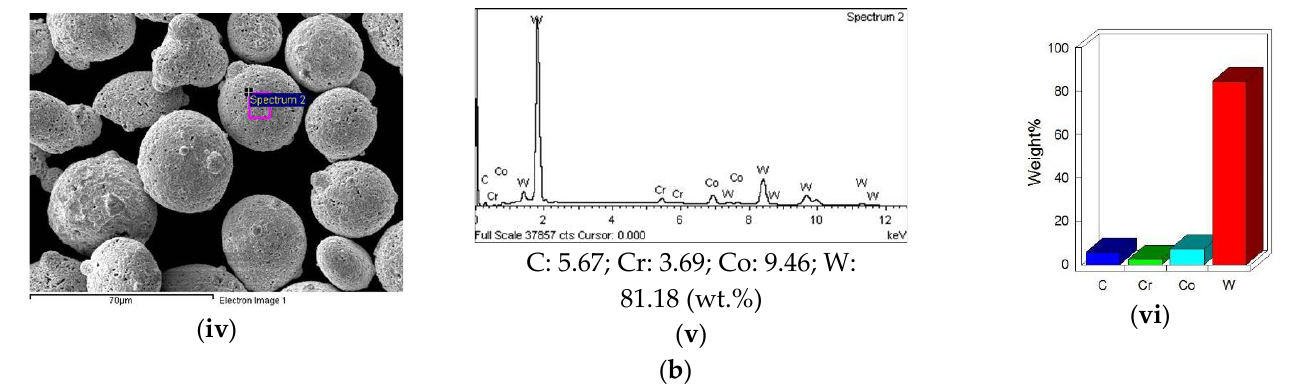
Figure 8. EDS characterization of: ( a ) WC-12Co and ( b ) WC-10Co-4Cr powder. ( i , iv ) Powder morphology; ( ii , v ) Element histogram; ( iii , vi ) Quantitative EDS results.